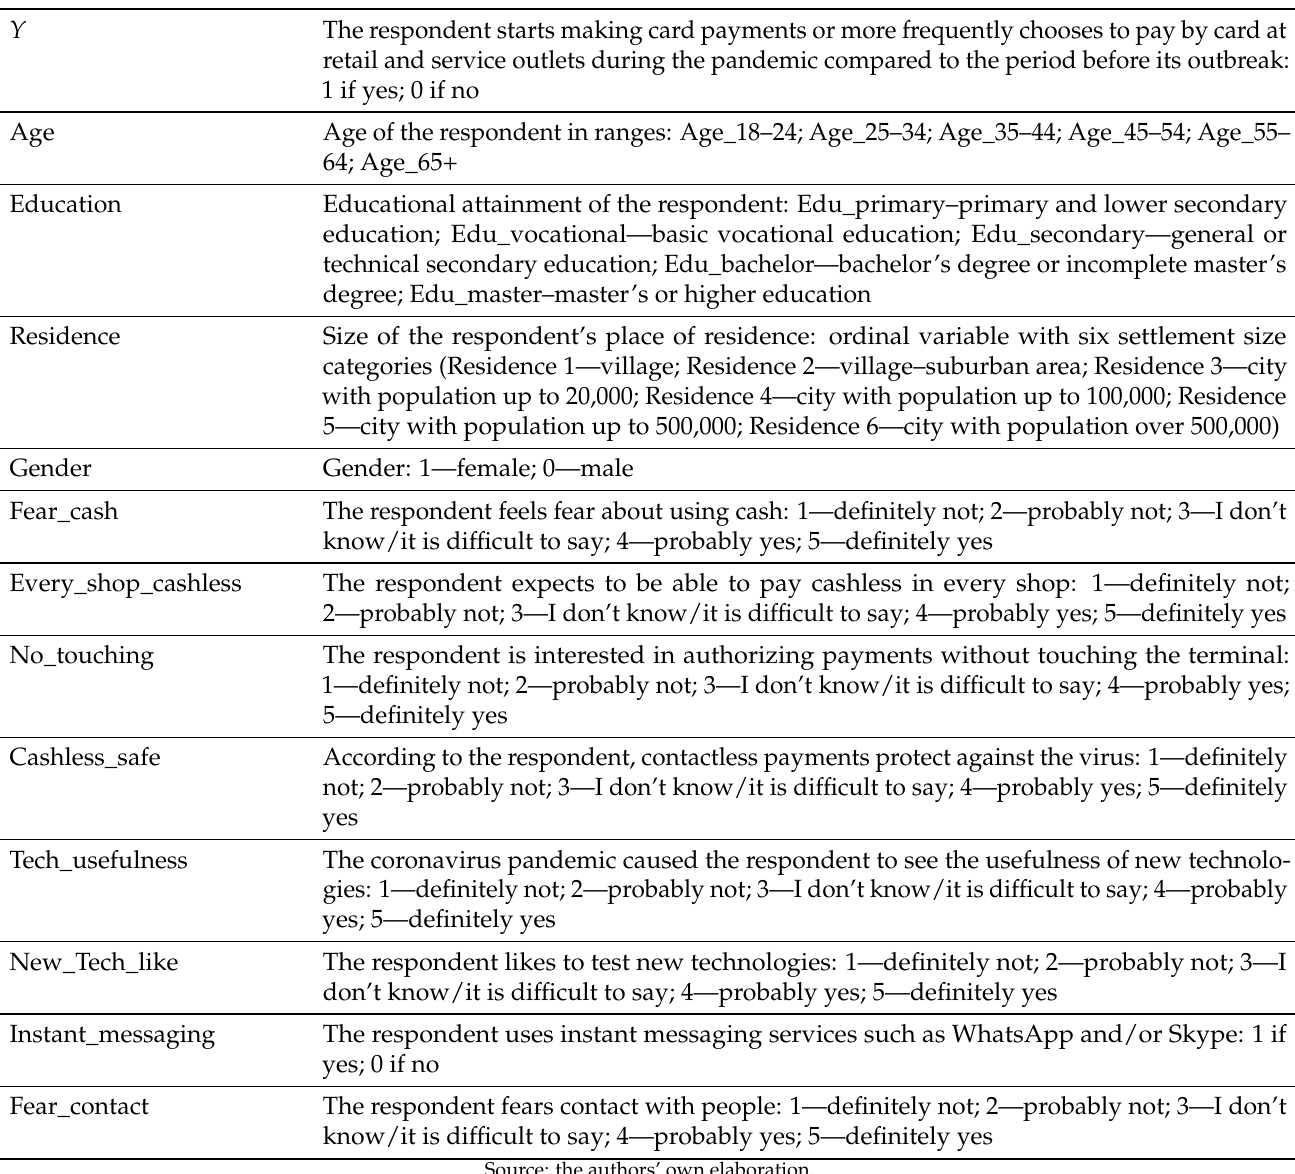
Table 2. Variables used in the empirical